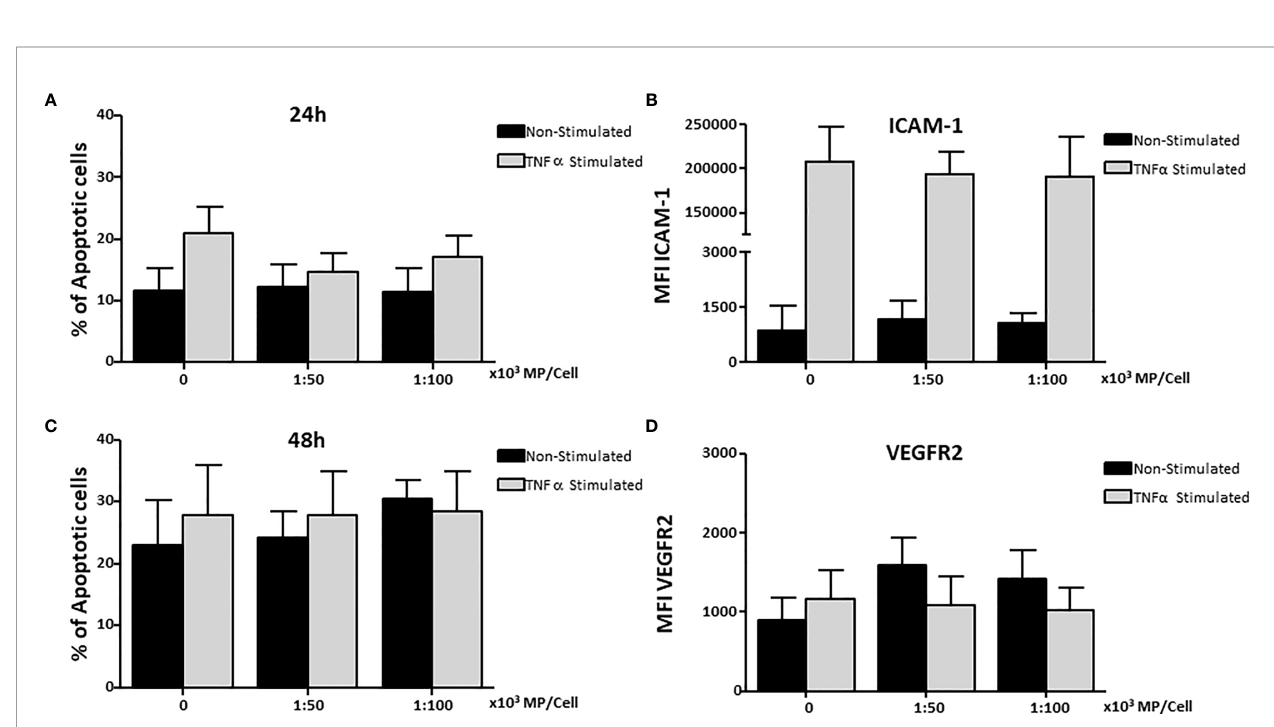
FIGURE 4 | Effect of Membrane Particles on HUVEC apoptosis and adhesion molecules. HUVEC were stimulated with TNF a and treated with two concentration of MP (1:50,000, 1:100,000) and incubated at (A) 24h, and (B) 48h for the analysis of apoptosis. Surface expression of adhesion molecules on HUVEC was measured at the time point of 24h (C) ICAM-1, and (D) VEGFR2. Values are means ± SD of the mean fl uorescent intensity of the receptors of 5 independent experiments each testing MP from 2 donors in each